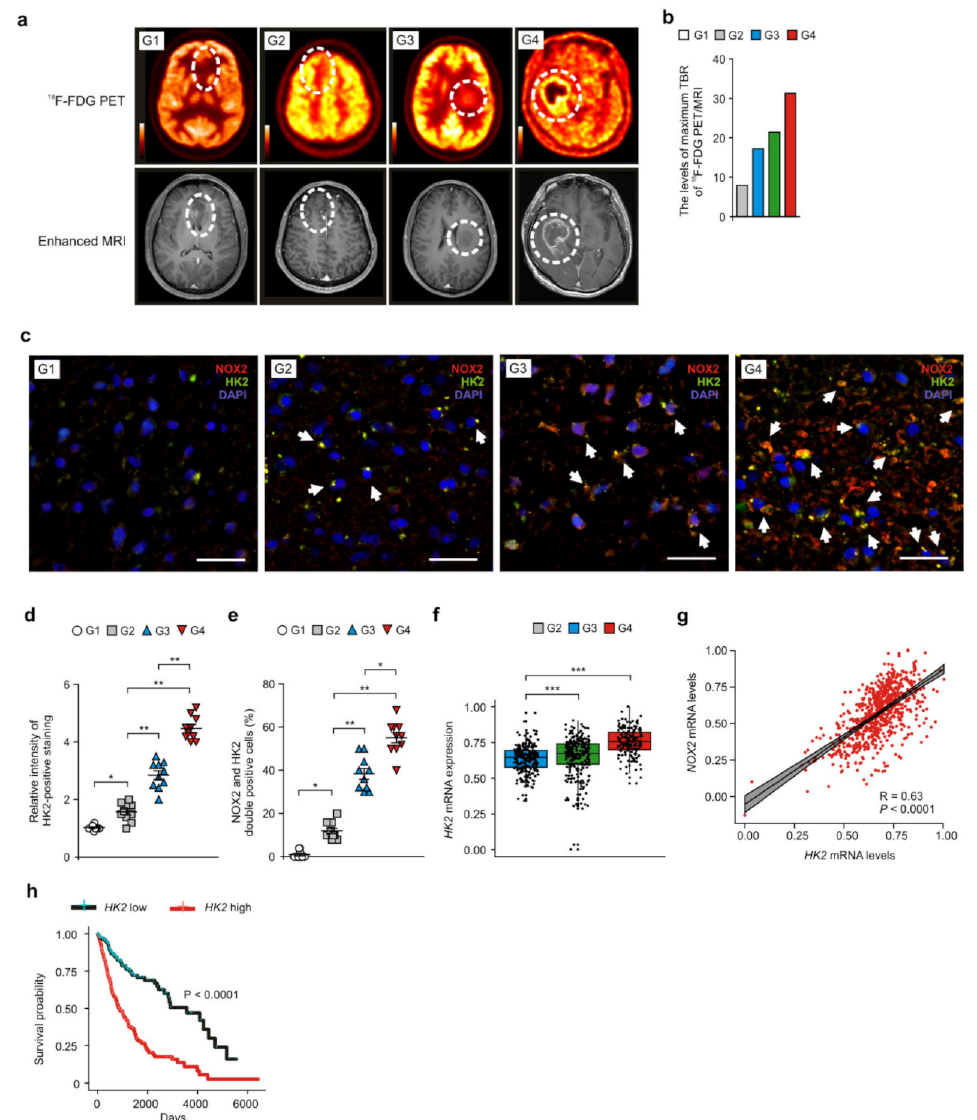
Figure 4. High levels of NOX2 contribute to high levels of glucose uptake and HK2 expression in patients with GBM. ( a , b ) Representative 18 F-FDG PET /MRI images ( a ) and quantification of maximum TBR levels for 18 F-FDG uptake ( b ) in brains from patients with GBM (G4), G3 glioma (G3), G2 glioma (G2), and G1 glioma (G1). ( c ) Representative immunofluorescence images of NOX2 and HK2 staining in patients with GBM (G4), G3 glioma (G3), G2 glioma (G2), and G1 glioma (G1) showing NOX2 (red), HK2 (green), and DAPI-stained nuclei (blue) (n = 3 per group, n = 10 images per individual subject). Scale bars, 20 µ m. White arrows indicate NOX2 and HK2-positive cells. ( d , e ) Relative intensity of HK2-positive staining ( d ) and quantification of NOX2 and HK2-positive glioma cells ( e ) from ( c ). ( f ) The levels of HK2 mRNA in patients with GBM and LGG datasets from TCGA. Wilcoxon test with two-sided and one-sided. ( g ) Spearman’s correlation coefficient analysis between NOX2 and HK2 genes in patients (n = 693) with GBM and LGG dataset from TCGA. R = 0.63, p < 0.0001. ( h ) The survival curve of patients with low (black) (n = 347) and high levels (red) (n = 346) of HK2 mRNA (n = 693) from GBM and LGG dataset from TCGA. The two groups were divided according to median value. p < 0.0001; Kaplan–Meier estimation test with two-sided and one-sided. The results are representative of three independent experiments and are shown as the mean ± SEM. *** p < 0.001, ** p < 0.01, * p < 0.05; ANOVA or Student’s two-tailed t